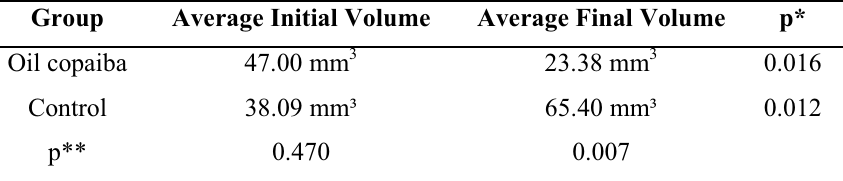
TABLE 1- Characteristics and results for a group of rats treated orally for 14 days